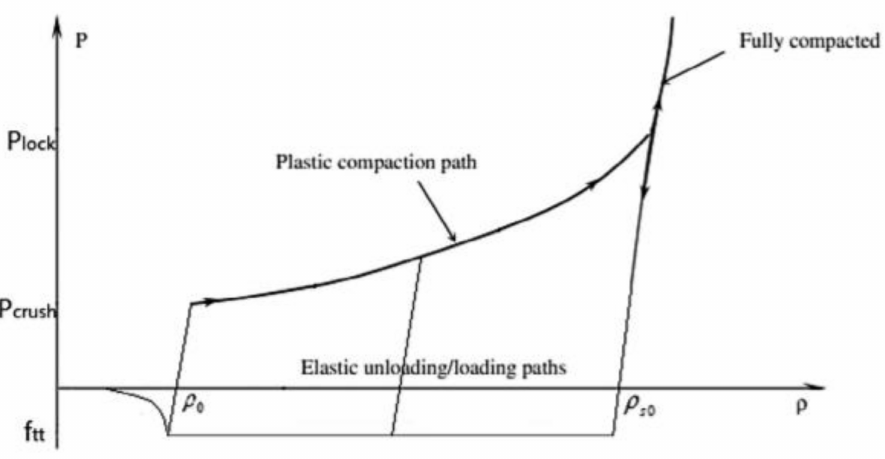
Figure 14. Pressure-volume response for concrete. Reprinted with the permission from [17], 2021,